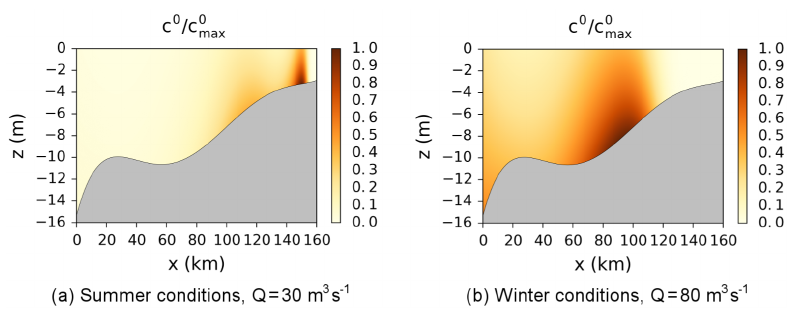
Figure 11. Tidally averaged sediment concentration for summer and winter conditions. Parameter values corresponding to the Scheldt Estuary.